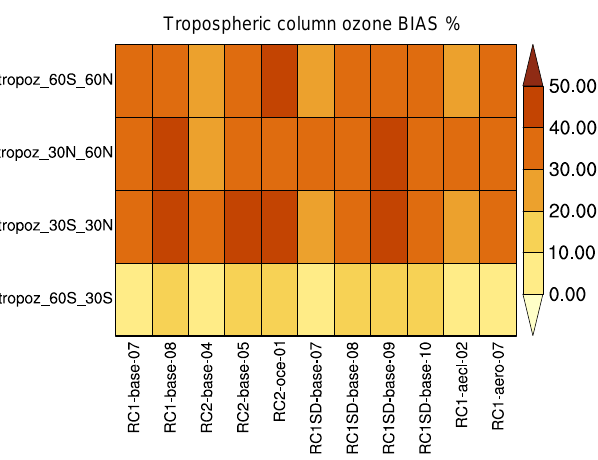
Figure 30. Same as Fig. 26, but for the tropospheric partial col- umn ozone. The reference data set is AURA MLS/OMI. All tiles are based on annual mean values of the years 2005 to 2011 and sta- tistically significant on the 90% confidence level. Here, the WMO tropopause definition has been used to be as consistent as possible with the reference data